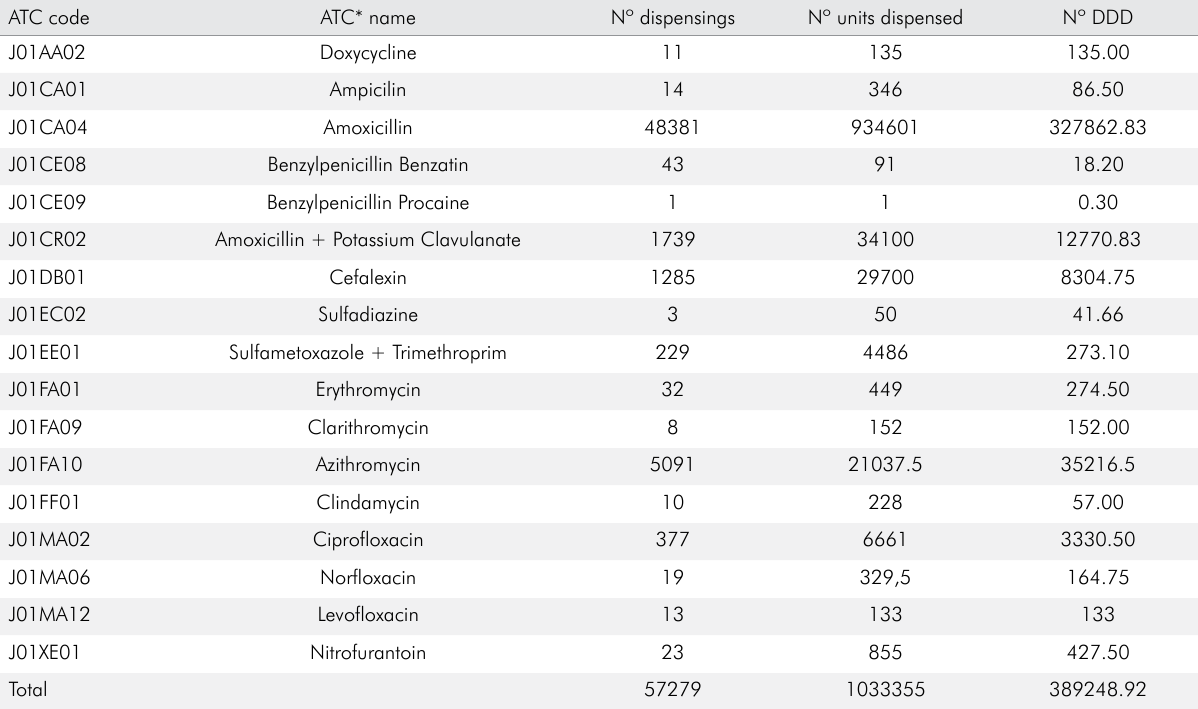
Table 3. Antibiotics prescribed by dentists and dispensed in the public health service, Minas Gerais, 2017 ATC